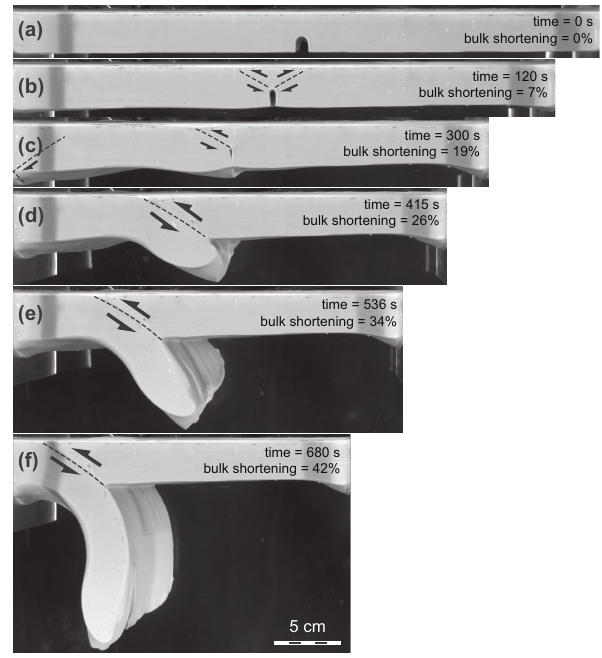
Fig. 11. Side views of Experiment 3. The model is composed of one single layer of mantle lithosphere with a notch in the middle of the plate’s length. The side pushed by the piston (i.e. right-hand side) becomes the upper plate while the other side slides down a newly created subduction